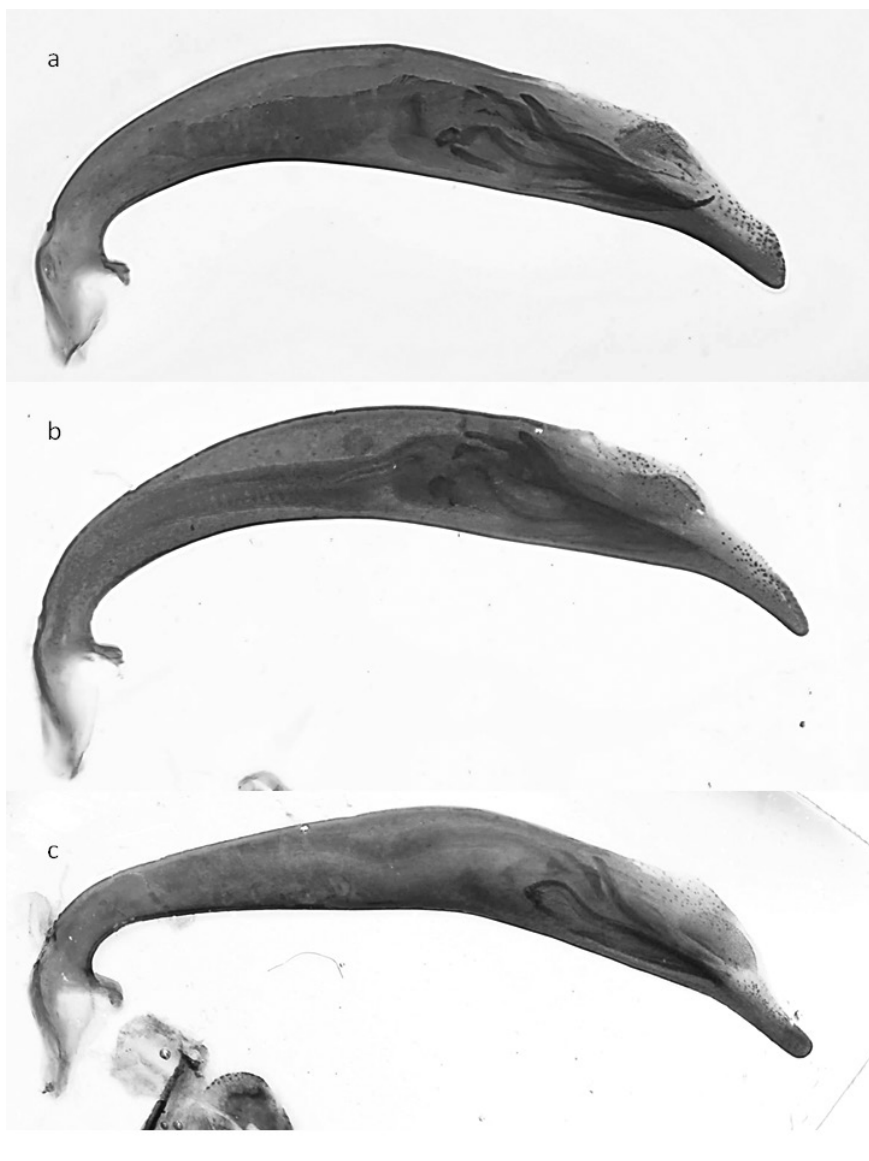
Figure 39. Median lobes of the aedeagus of Cicindela species : a, b C. javetii and c C. herbacea . evagination of the internal sac is not feasible for many entomologists. However, clear differences in the ratio internal sac to aedeagus length can usually be seen in embedded median lobes of aedeagus (Fig. 39). The body lengths of C. javetii and C. herbacea are not a good diagnostic character as the specimens in our collections show a stronger overlap than expected based in Deuve